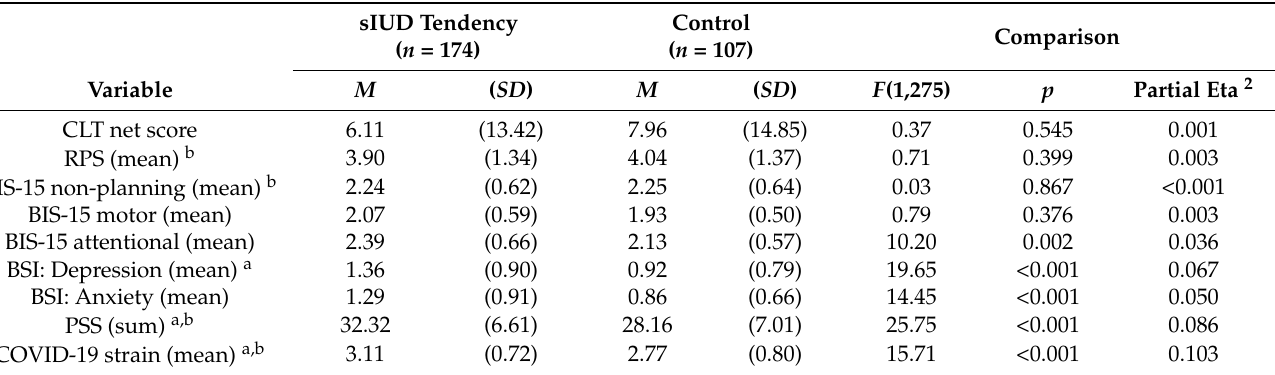
Table 1. Descriptive statistics and group